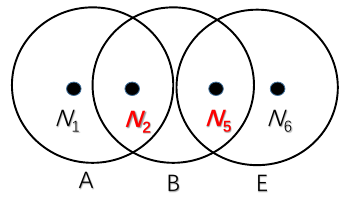
Figure 6. Relationships between the